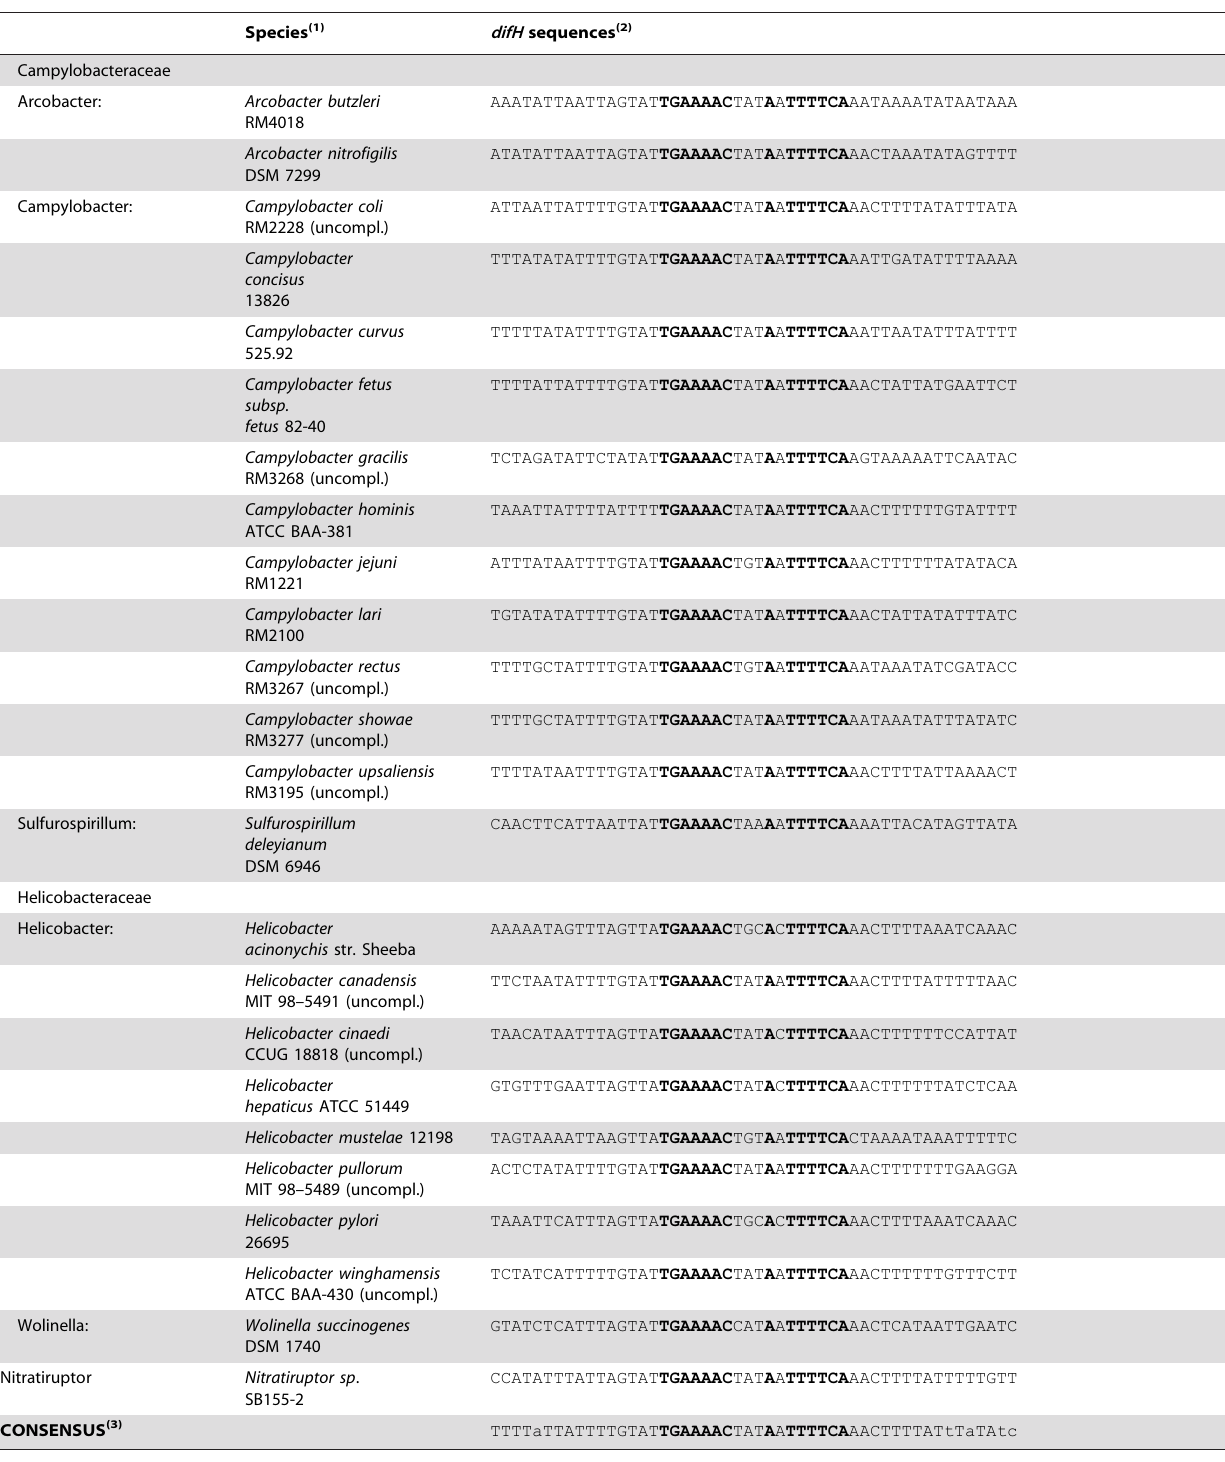
Table 2. Consensus dif H sequence obtained from 24 epsilon proteobacteria species.